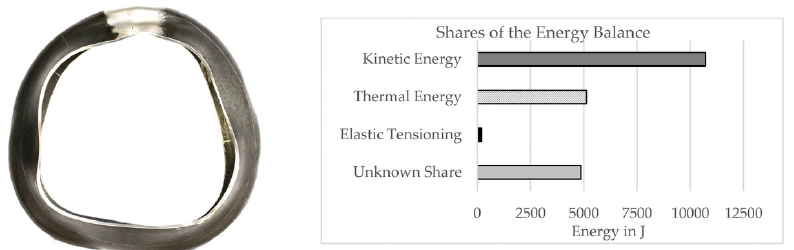
Figure 18. Burst containment and corresponding energy balance showing the shares, in which the kinetic energy of the rotor is transformed into.